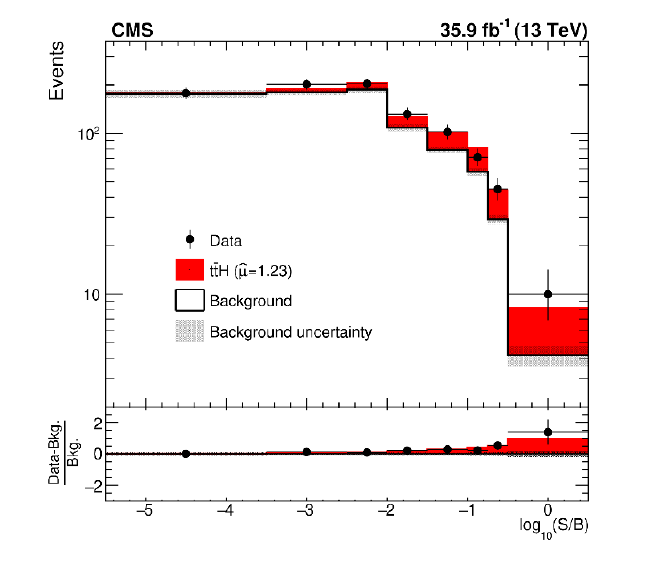
Figure 5 . Distribution of the decimal logarithm of the ratio between the expected signal and expected background in each bin of the distributions used for the signal extraction. The distributions expected for signal and background processes are shown for the values of nuisance parameters obtained from the combined ML (cid:12)t and (cid:22) = ^ (cid:22) = 1 : 23, corresponding to the best-(cid:12)t value from the ML